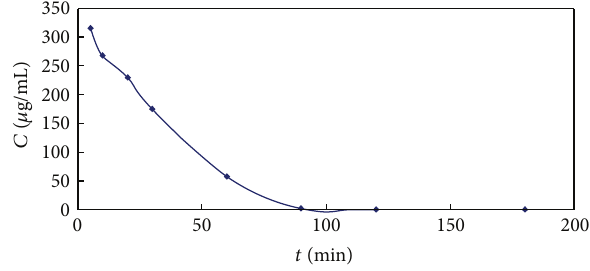
Figure 3: Profile of total drugs concentration versus time curve in rats plasma with 4 components and potential metabolites after Yangxue injection administration.